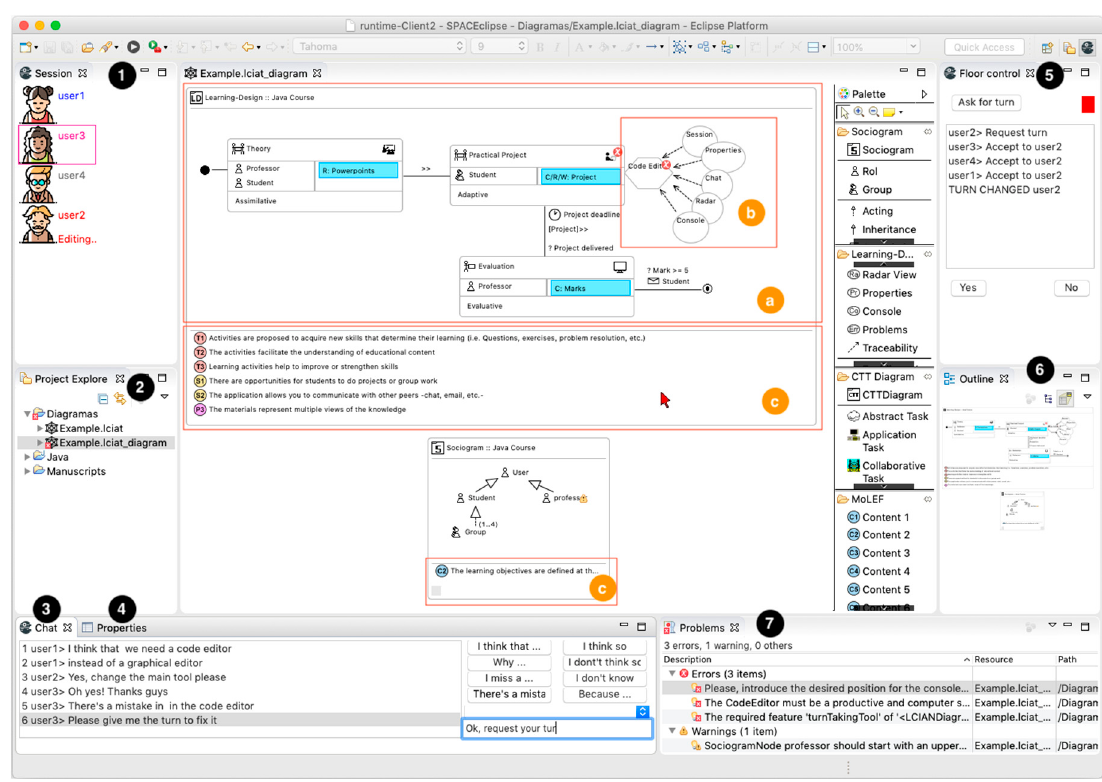
Figure 4. A collaborative modeling and validation process on